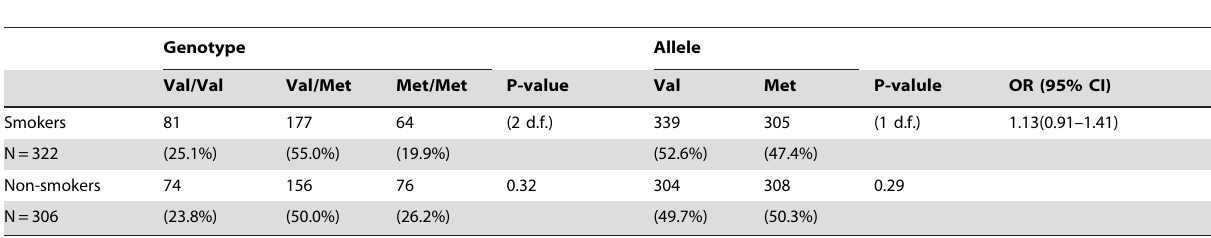
Table 2. Allele and genotype frequencies of BDNF-Val66Met polymorphism for smokers and non-smokers.